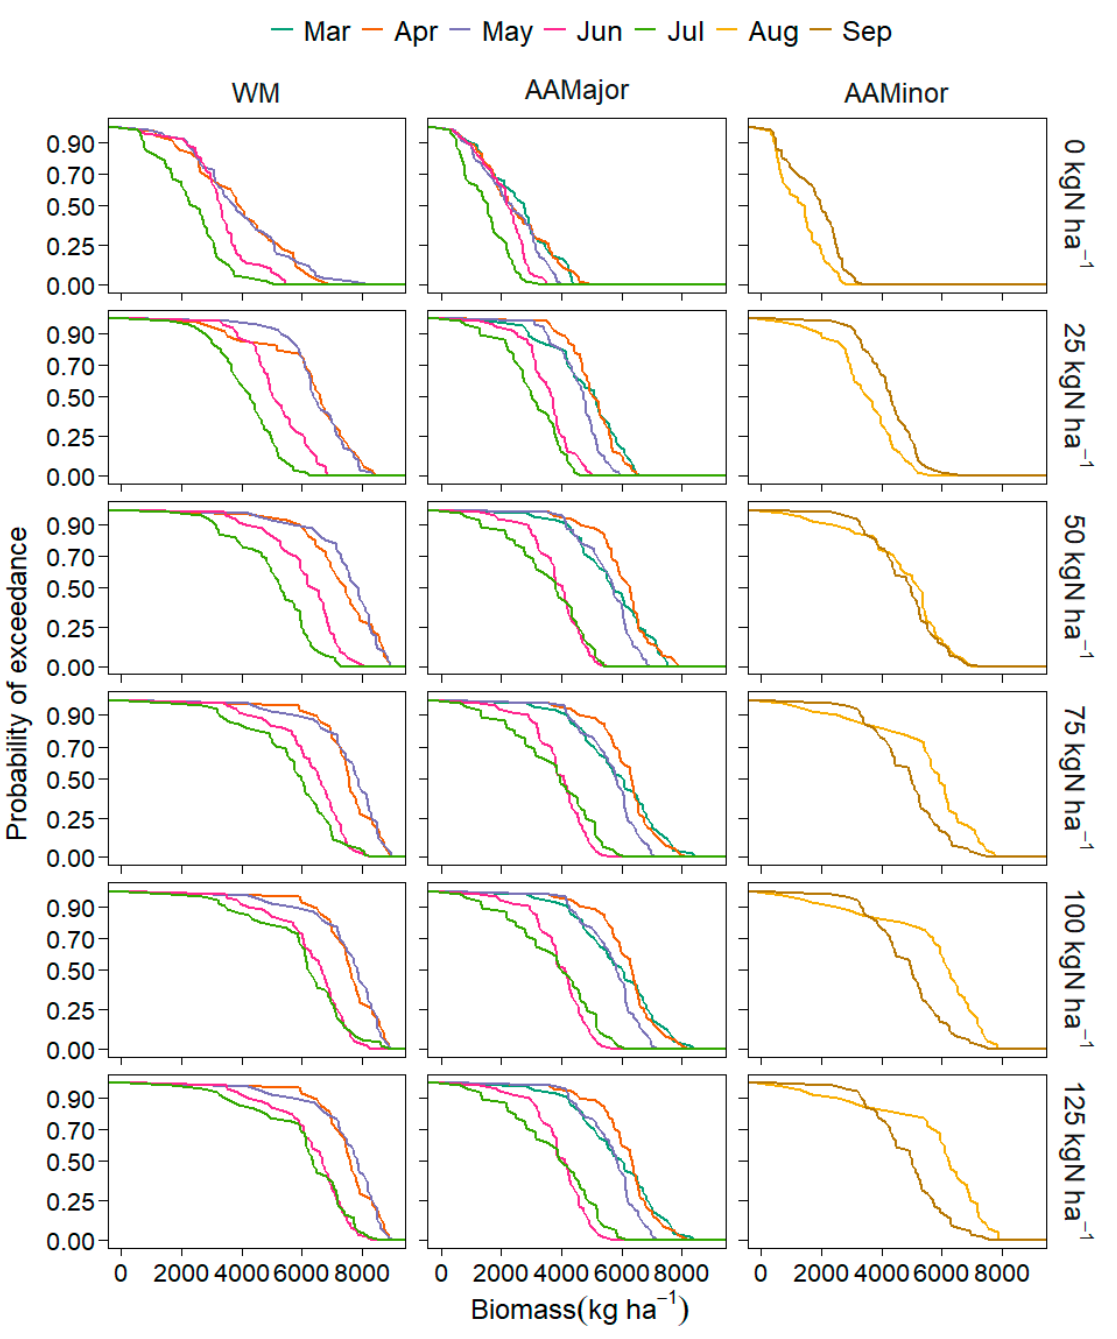
Figure 7. Simulated maize biomass under 6 N rates, various sowing windows, and rooting depth of 1.20 m for West Mamprusi (WM), major season Atebubu-Amantin (AAMajor) and minor season Atebubu-Amantin (AAMinor).